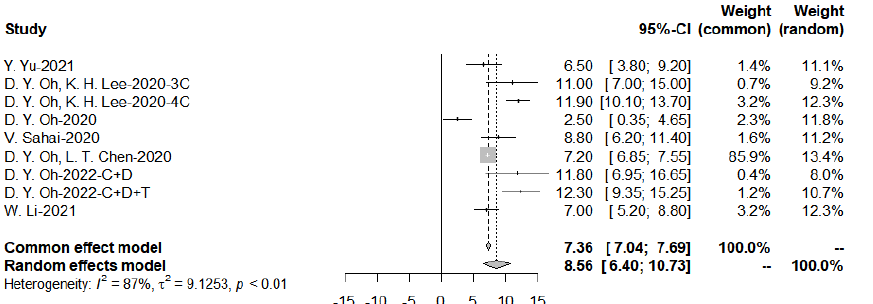
Figure 13. Progression ‐ free survival with immunotherapy and funnel plot.